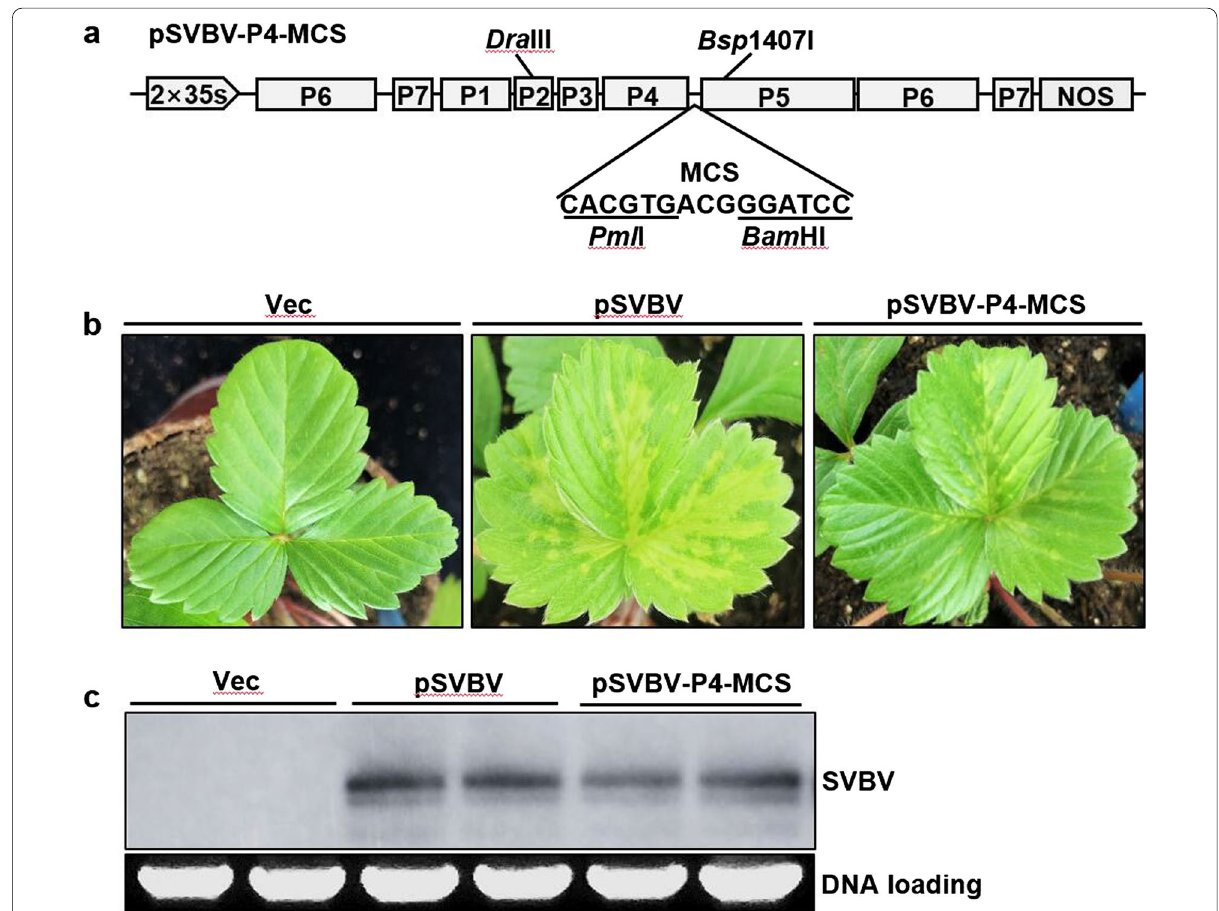
Fig. 3 The recombinant virus vector pSVBV-P4-MCS could induce systemic infection in strawberry plants. a Schematic representation of the pSVBV-P4-MCS vector. The MCS sequence was CAC GTG ACG GGA TCC , with the underlined part representing the recognition sequence of restriction endonucleases Pml I and Bam HI. The fragment P4-MCS was cloned into the plasmid pSVBV via the Dra III/ Bsp 1407I sites to generate pSVBV-P4-MCS, which has a MCS downstream of the P4 gene; b Light-green vein banding symptoms in strawberry plants agroinfiltrated with pSVBV or pSVBV-P4-MCS. Strawberry plants agroinfiltrated with pCB301 were used as negative controls; c Accumulation of SVBV in pCB301-, pSVBV-, or pSVBV-P4-MCS-agroinfiltrated strawberry plants by Southern blot analysis. SVBV DNA was detected using a digoxigenin-labeled probe specific for the SVBV CP gene. The lower panel represents an ethidium bromide-stained gel of DNA samples as a loading